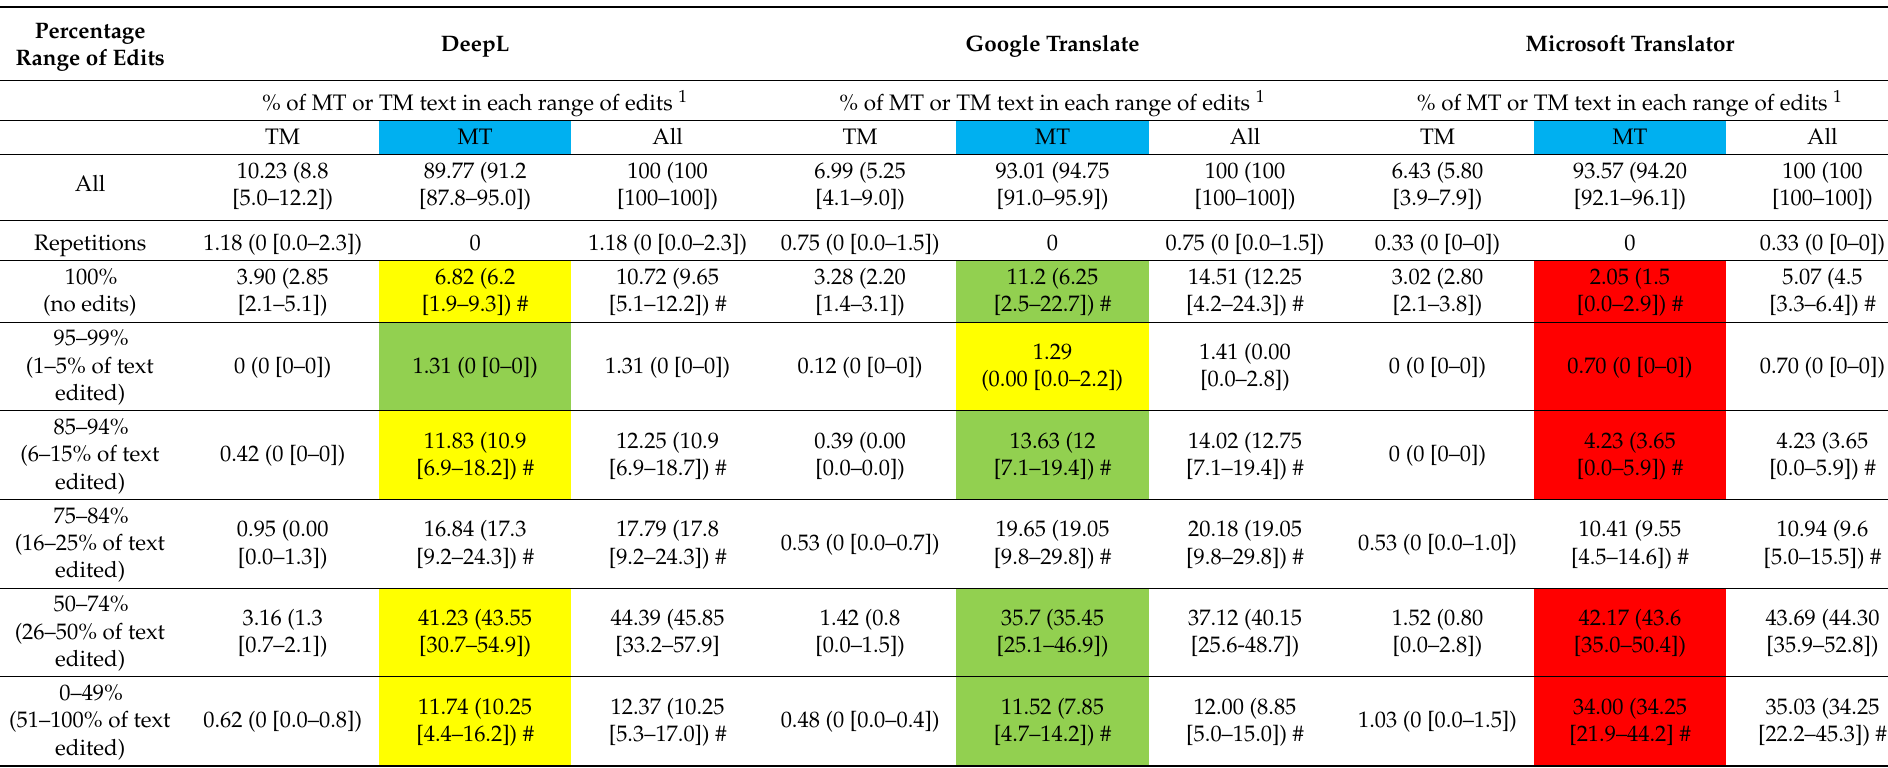
Table 4. Results of Post-editing 2 analysis per MTE—the average percentage (median) of post-edited MT and TM matches per range of edits after two editing